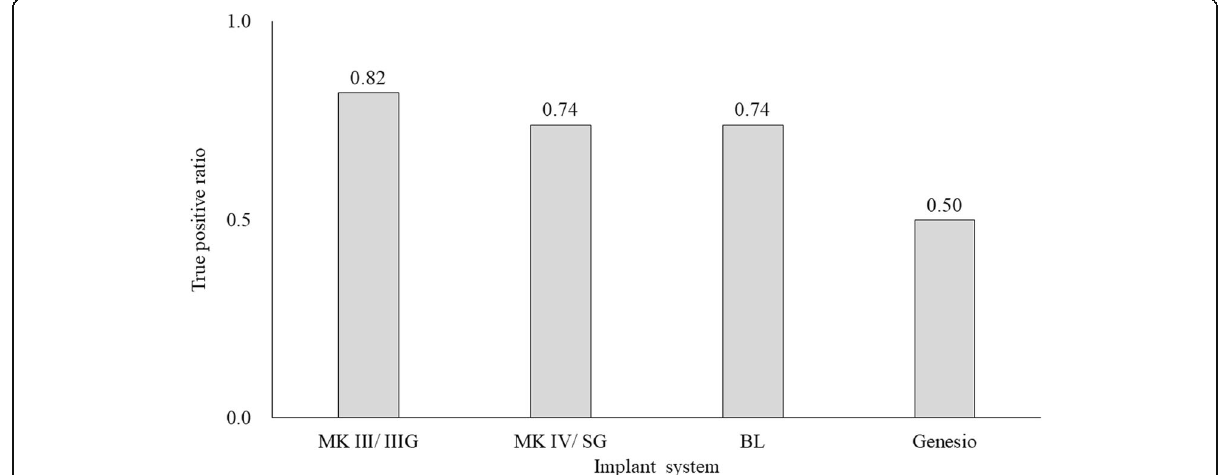
Fig. 4 Ratio of implant systems detected correctly to all detected systems (True Positive ratio). MK III/MK III Groovy: MK III/IIIG, MK IV/Speedy Groovy: MK IV/SG, bone level: BL and Genesio Plus ST: